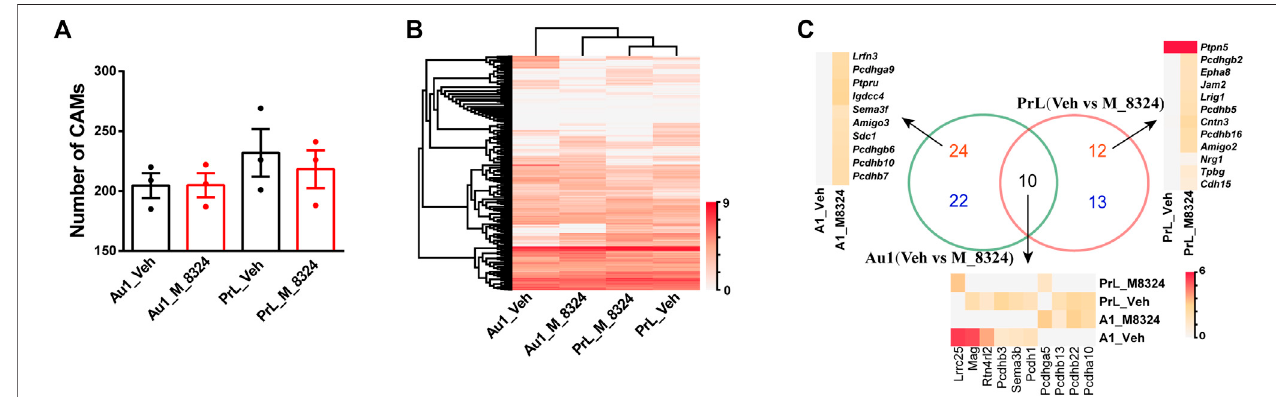
FIGURE 6 | Distinct gene expression patterns of cell adhesion molecules in PV-neurons after 7-days M-8324 treatment. (A) Numbers of all detected CAMs were not different between Veh and M-8324 in both Au1 and PrL-PFC. (B) Clustering heatmap of expression pattern of all detected CAMs in PV-neurons after M-8324 treatment in Au1 and PrL-PFC. (C) A Venn diagram showing difference and similarity of differential CAMs after M-8324 treatment between Au1 and PrL-PFC. Red numbers indicate the number of up-regulated genes, blue the down-regulated genes, and black the differential genes shared. Heatmap and names of the up- regulatedgeneswithexpressionvalue ≥ 4.0ineithergroupinAu1(top10)andallup-regulatedgenesinPrL-PFCwereshowedbesidestheVenndiagram.Heatmapand names of all differential genes shared by Au1 and PrL-PFC were shown under the Venn diagram. Standardized method of the heatmaps: log(value